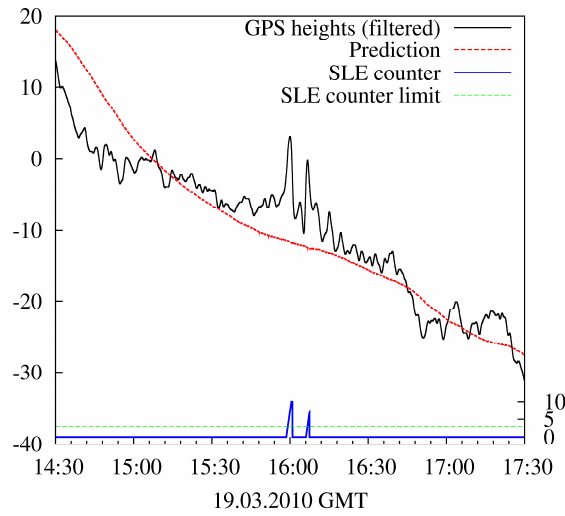
Figure 6: GPS derived sea level time series (in cm) of a typical tsunami alert sequence in GITEWS (~3 hours length). The prediction (red) is based on the SLE algorithm (see Sect. 5 in Pérez et al., 2009). The difference to a model is in the range of 5 cm. Under normal conditions, tsunamis with amplitudes of 10 cm can be detected. The graph shows the GPS-derived sea level time series (black) and the prediction (red) in cm (left hand side axis). The right hand side axis is the SLE trigger (value between 1 and 10) (blue) and the SLE counter limit (here 3) for tsunami alerting (green).